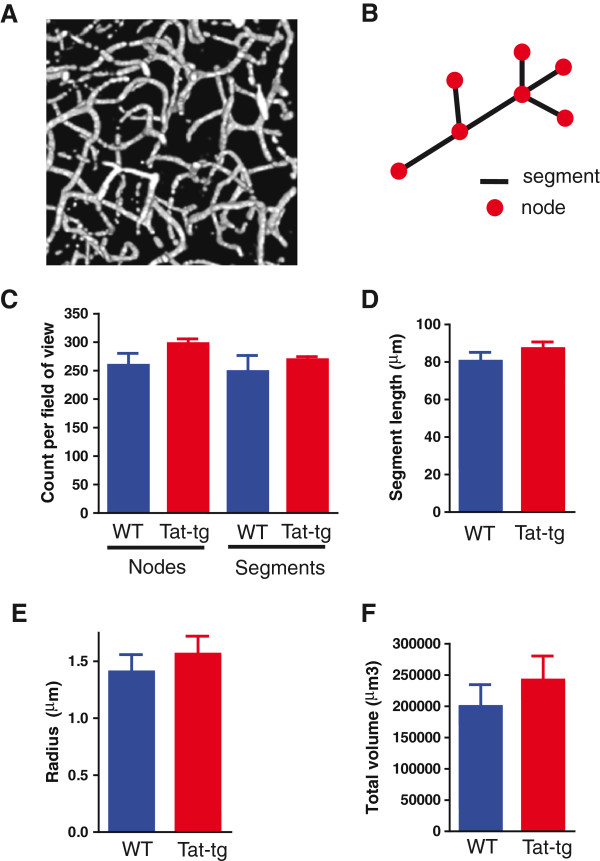
Cortical capillary morphology is not changed in Tat-transgenic (Tat-tg) mice. (A) Representative image of three-dimensional stacks of cortical tissue capillaries (10x magnification) used for skeletonization with the filament tool in Amira software. (B) Schematic of vessel branching used for quantification of morphological features in the skeletonized images. (C) The number of nodes and segments in wild type (WT) and Tat-tg mice. (D) Mean length of segments. (E) Mean radius of vessels. (F) Total volume of vessels in one 3-dimensional image stack (500 μm x 500 μm x 100 μm). (C-F) Data extracted from same animals, seven WT and seven Tat-tg. Data represent mean ± SEM. Comparison of cortical capillary parameters from WT and Tat-tg failed to reach statistical significance